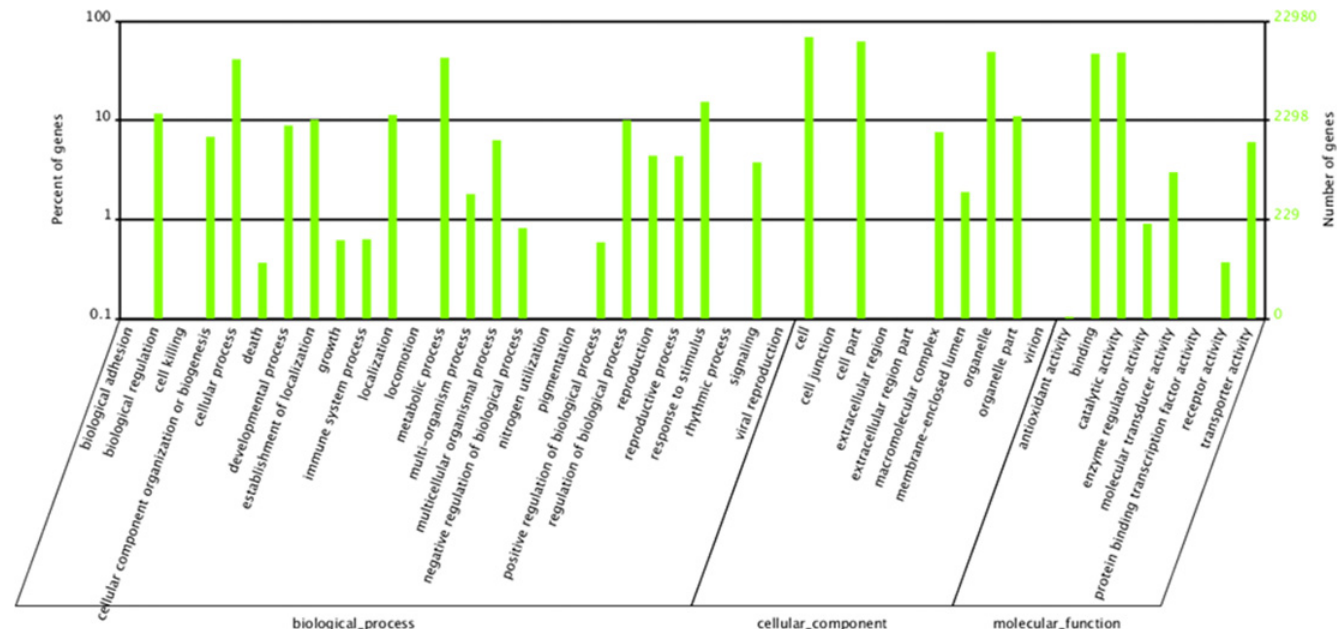
Fig 3. Gene Ontology (GO) categories of the assembled American ginseng unigenes. The unigenes were assigned to the three GO categories: biological process, cellular component, and molecular